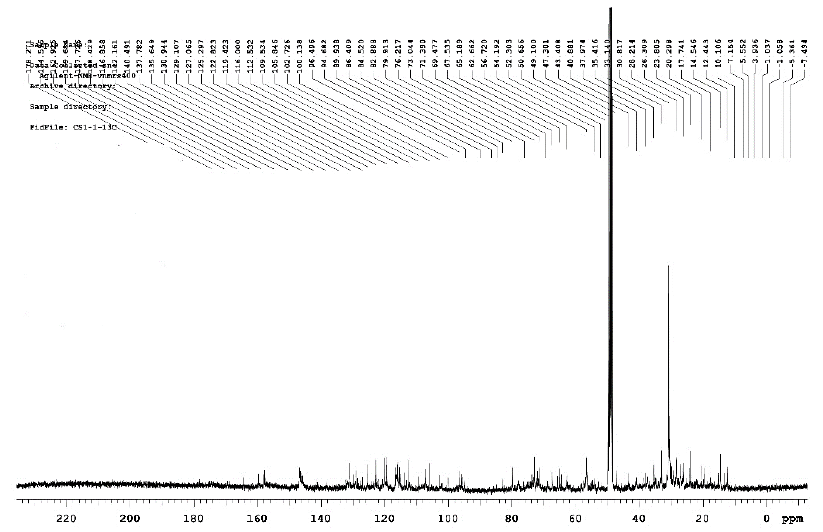
Figure 7. 13 C-NMR spectra of RPB sample.